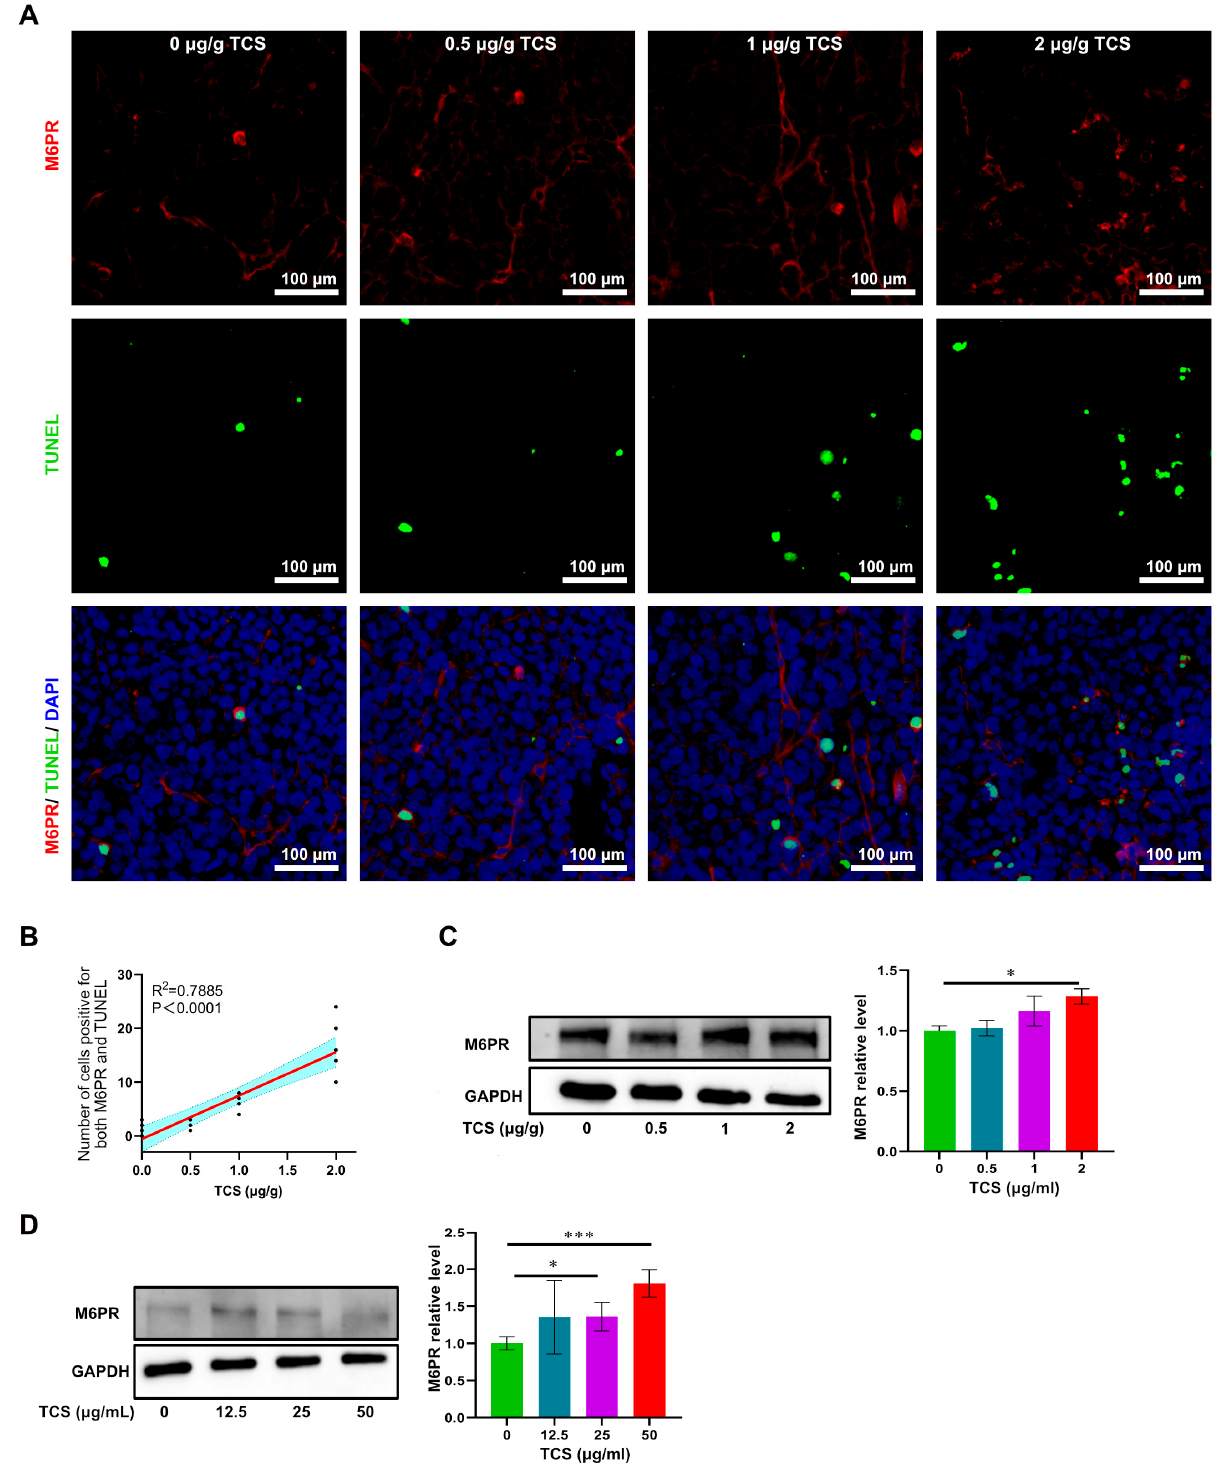
Figure 8. TCS promotes M6PR expression in vivo and in vitro. ( A ) Immunochemical method detected GrzB and M6PR in HCC tissues upon TCS treatment. Bar = 100 µ m; ( B ) Correlation analysis of the number of simultaneous positive signals of GrzB and M6PR with the dose of TCS; ( C ) Western blot method detected the levels of M6PR in HCC tissues treated with different doses of TCS (0, 0.5, 1 and 2 µ g/g); ( D ) Western blot method detected the levels of M6PR in H22 HCC cells treated with different doses of TCS (0, 12.5, 25 and 50 µ g/mL). *, p < 0.05; ***, p < 0.001.